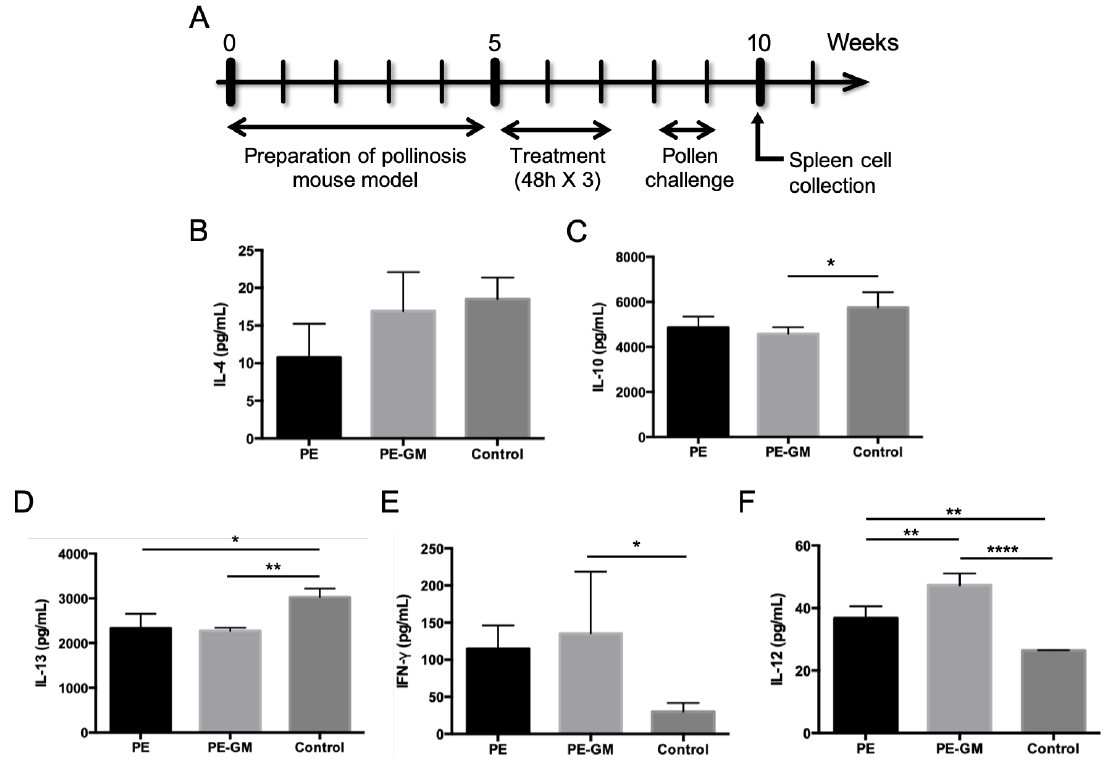
Figure 5. ( A ) The schedule of sensitization and immunotherapy. Levels of ( B ) IL-4, ( C ) IL-10, ( D ) IL-13, ( E ) IFN- γ and ( F ) IL-12 allergen-induced type 1 T helper (Th1) and type 2 T helper (Th2) cytokines produced by splenic cells isolated from mice as measured by enzyme-linked immunosorbent assay (ELISA). Splenocytes were isolated from B10.S mice immunized by the transcutaneous administration of PE and PE-GM in S / O nanodispersions. Splenocytes were stimulated with PE (50 µ g / mL) for three days. n = 4, mean ± SE. * p < 0.05, ** p < 0.01, **** p < 0.0001.